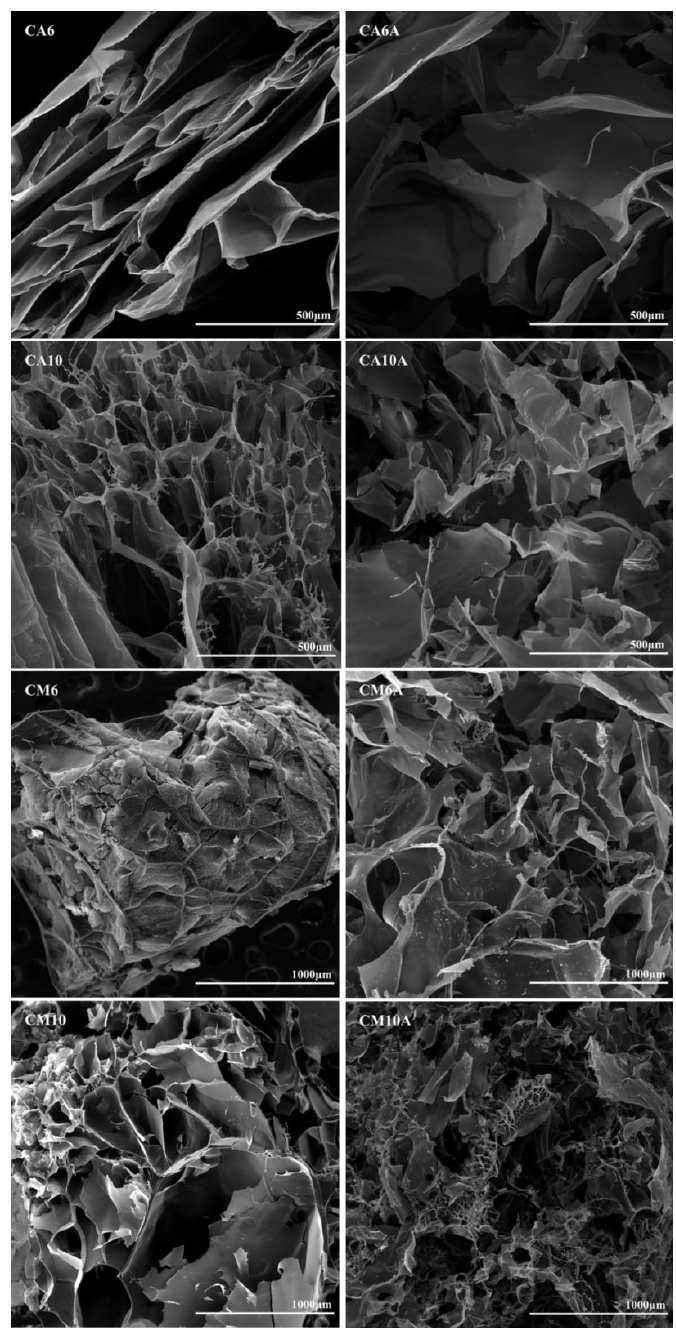
Figure 4. SEM images of hydrogels with acrylic and methacrylic acid, obtained with 0.6% or 1% APS, before and after arginine immobilization.